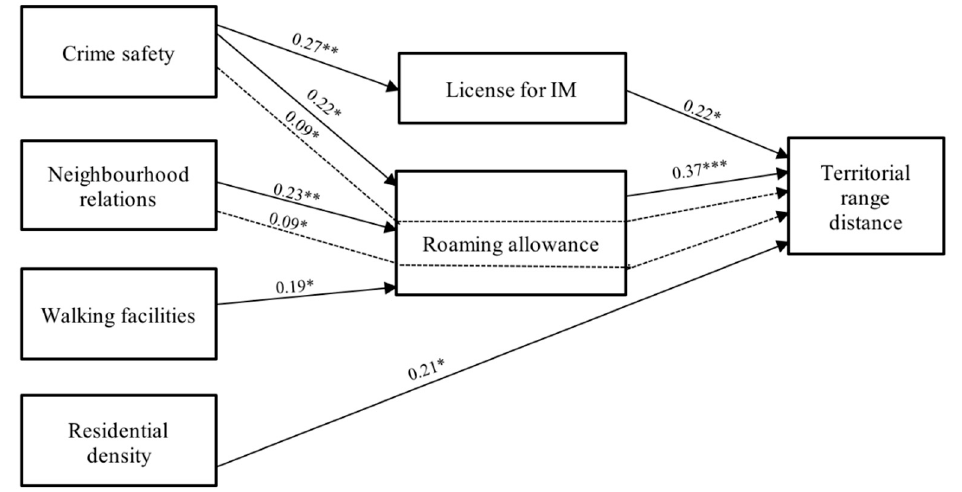
Figure 3. Summary of pathways for significant direct and indirect effects for territorial range distance. All path coefficients were standardized. Solid lines indicate direct effects, dashed lines indicate indirect effects. * p < 0.05, ** p < 0.01, *** p < 0.001; IM: independent mobility.